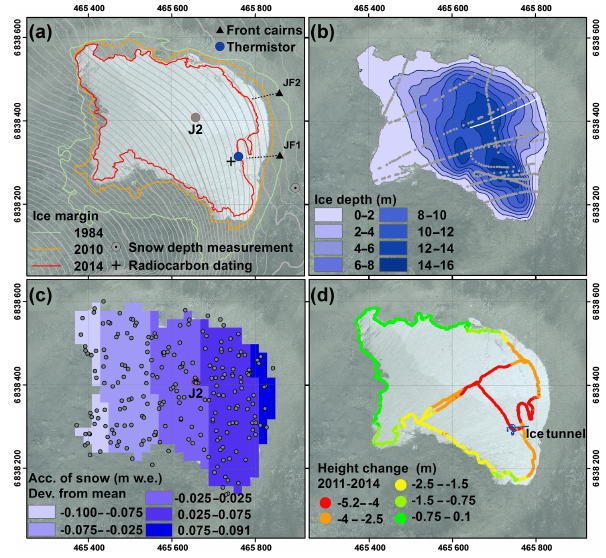
Figure 3. Maps of Juvfonne with orthophotos from September 2011 as background (UTM coordinates zone 32 ◦ N): (a) ice margins, po- sition of front measurements (JF1 and JF2, see Fig. 9), position of mass balance stake J2, position of thermistor for ice temper- ature measurements (Fig. 13) and position of the oldest radiocar- bon dating and position of snow depth measurement station; (b) in- terpolated contours of bed topography relative to ice thickness in September 2011 (grey markers are radar points used in the inter- polation) and position of the georadar track in Fig. 4, white line; (c) grey markers are snow depth measurements (2010–2015), while the raster map shows a first order polynomial fit to the deviation from mean accumulation each year; and (d) height differences along GNSS tracks in 2014 relative to ice surface from laser data in 2011 and positions of the ice tunnel excavated in